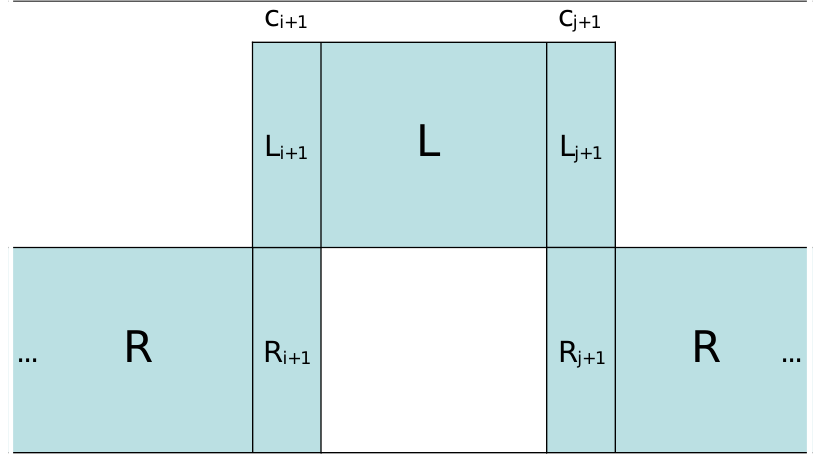
Figure 6 . Overlapped positive matrices Y L and Y R with two c i ’s on top of